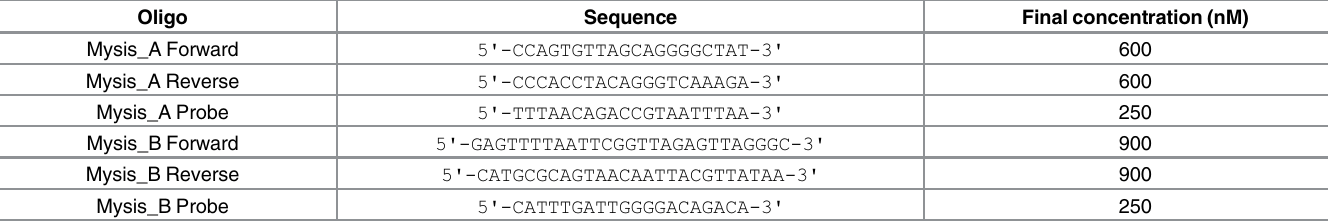
Table 2. Primer and probe sequences for the Mysis_A and Mysis_B markers. Oligo